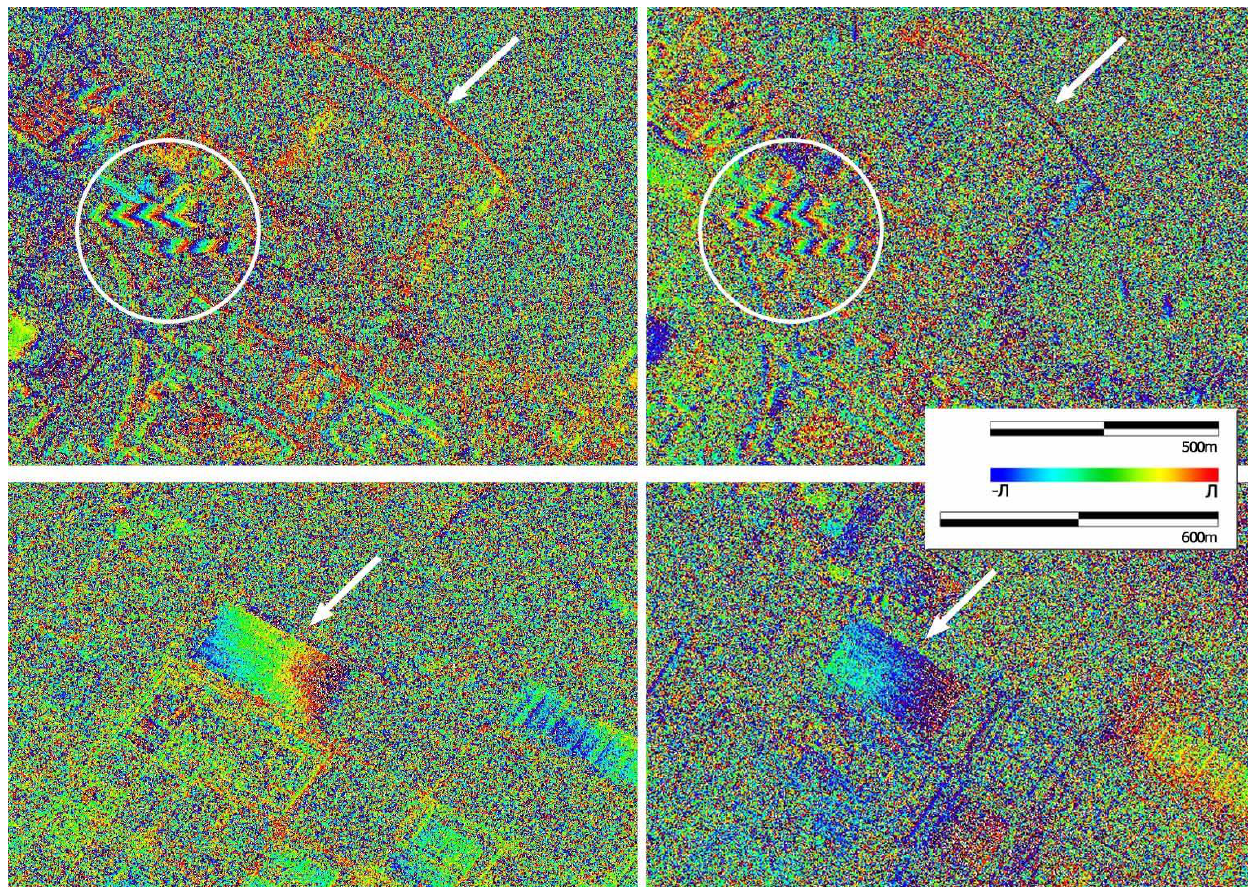
Figure 3. X-band interferometric phases from TerraSAR-X (left) and CosmoSkyMed